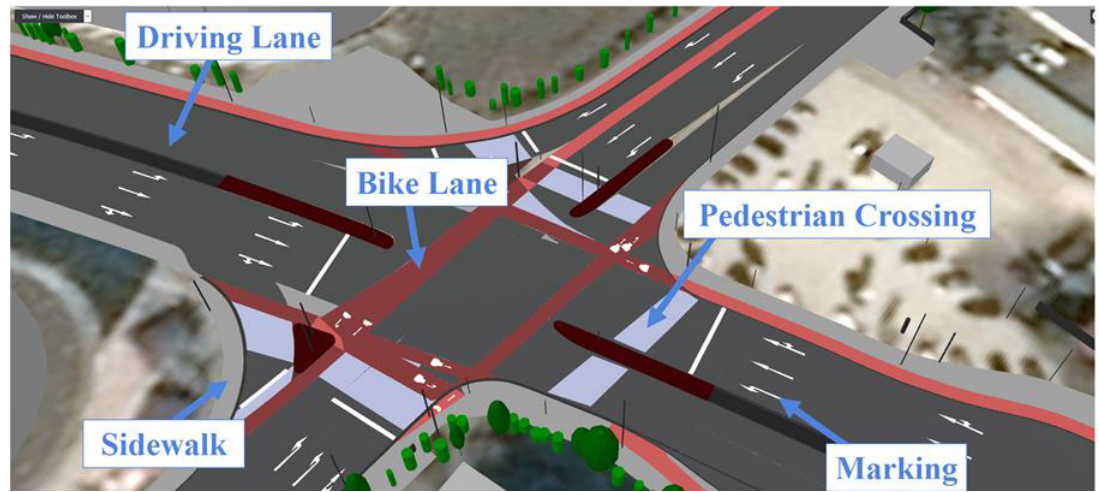
Figure 14. Complex intersection including multi-functional TrafficAreas and Markings.